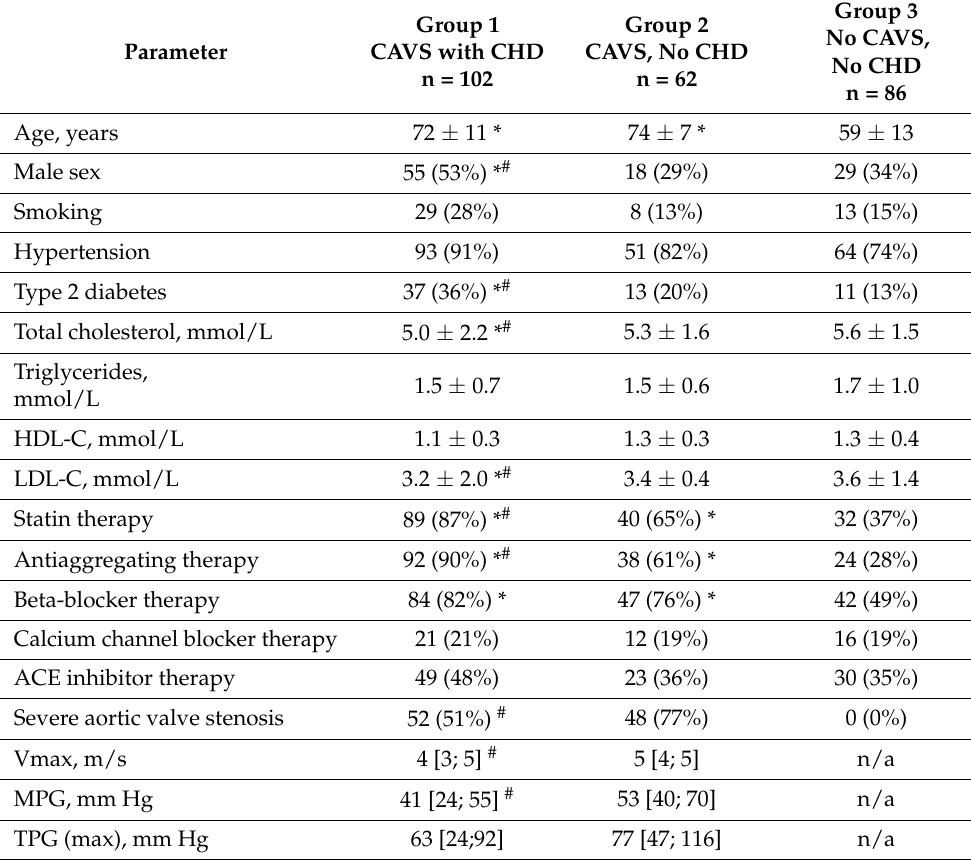
Table 1. General characteristics of